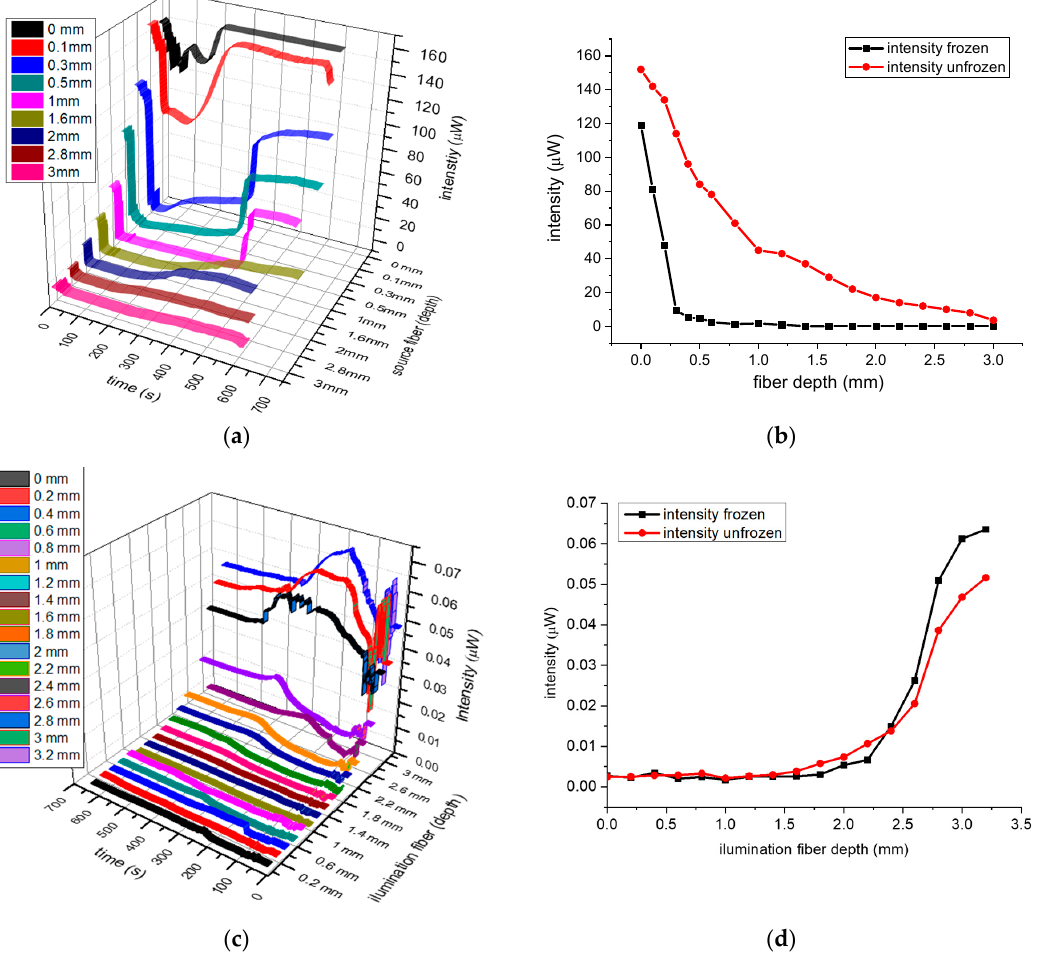
Figure 3. ( a ) Typical transmission and ( c ) backscattering through 0.0 mm, 3.2 mm embedded fiber in skin tissue; ( b ) collective transmission; and ( d ) collective backscattering in frozen and unfrozen tissue.